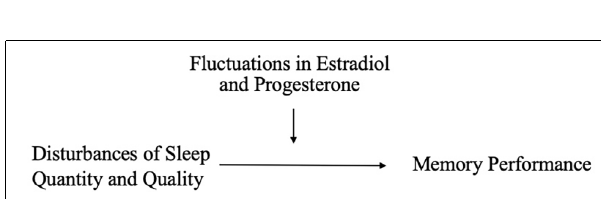
FIGURE 2 | Reduction in sex hormones as a mediator of associations between poor sleep and memory performance.